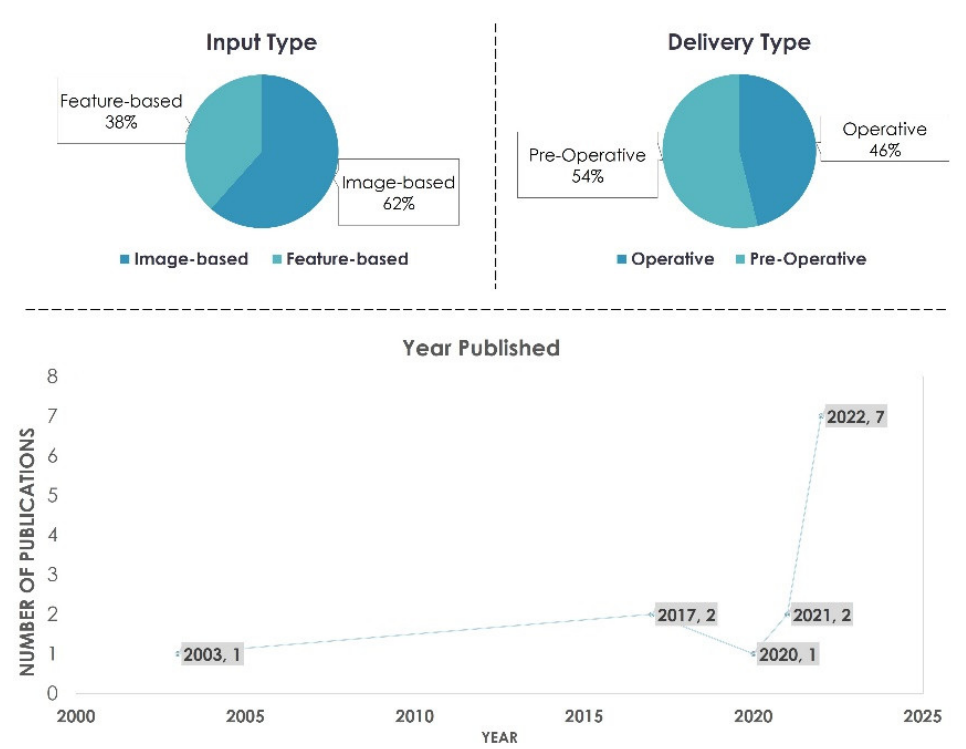
Figure 2. Analysis of the identified literature.